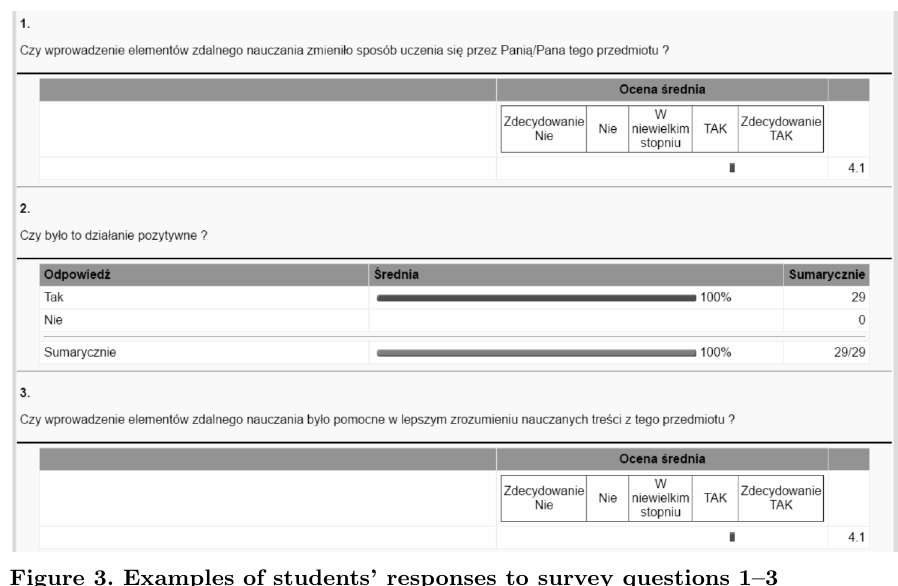
Figure 3. Examples of students’ responses to survey questions 1–3